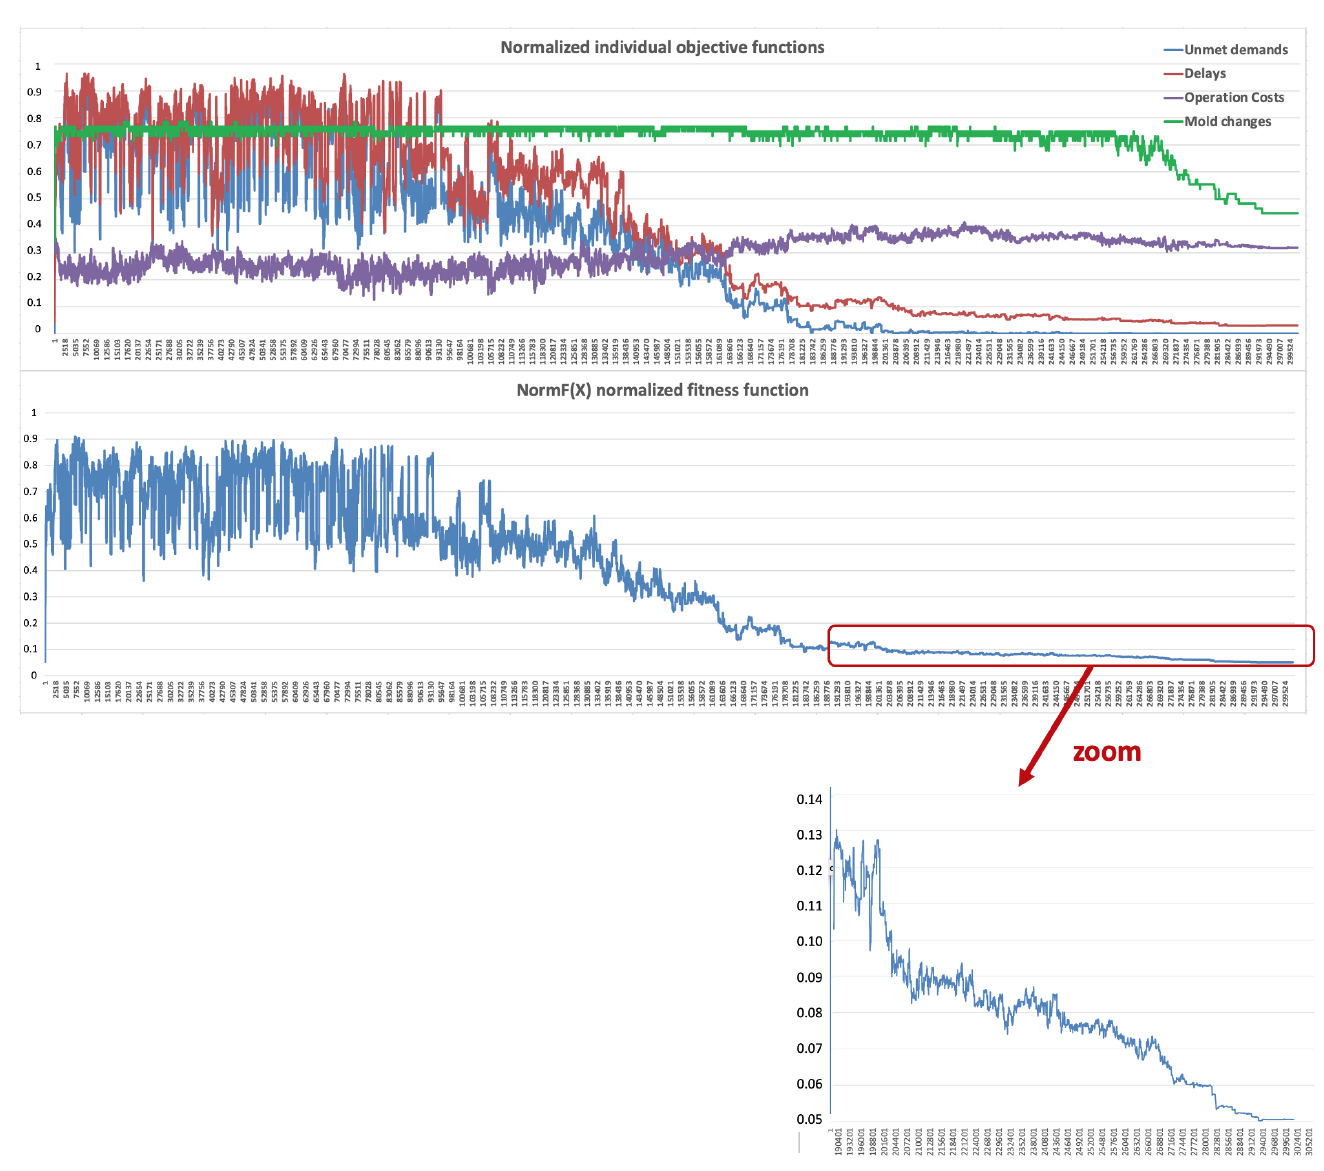
Figure 7. Simulated annealing (SA) evolution.